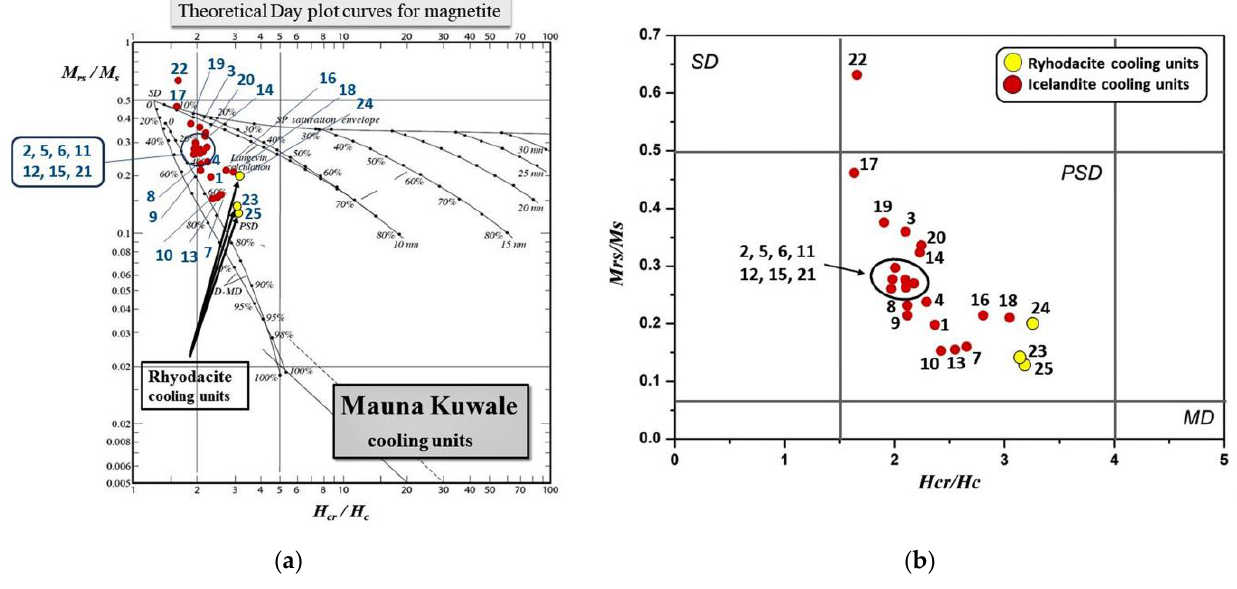
Figure 6. Day-Dunlop diagrams of hysteresis parameters [34]. Notice the magnetic grain sizes mainly located within the PSD areas of the diagrams, ( a ) Theoretical Day plot curves for magnetite; ( b ) Day diagram showing the magnetic domain boundaries of SD, PSD and MD Table 2. Hysteresis results and parameters. Hcr — remanence coercivity; Hc — coercivity; Mrs — rem-